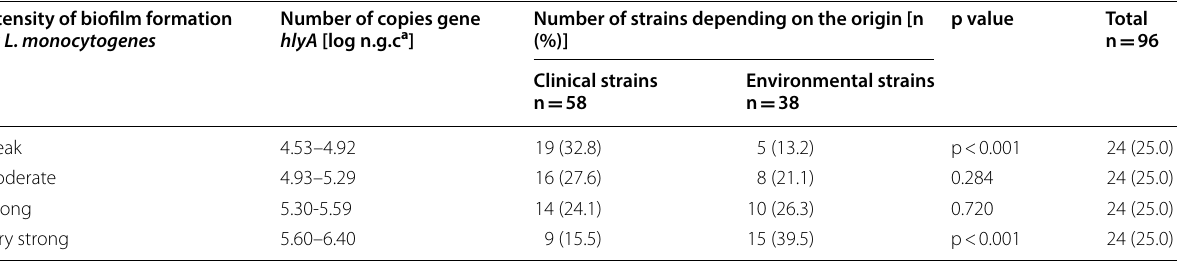
Table 5 Classification of tested L. monocytogenes rods depending on the biofilm formation ability on the polypropylene surface based on the number of copies of the hlyA gene assessed by droplet digital PCR